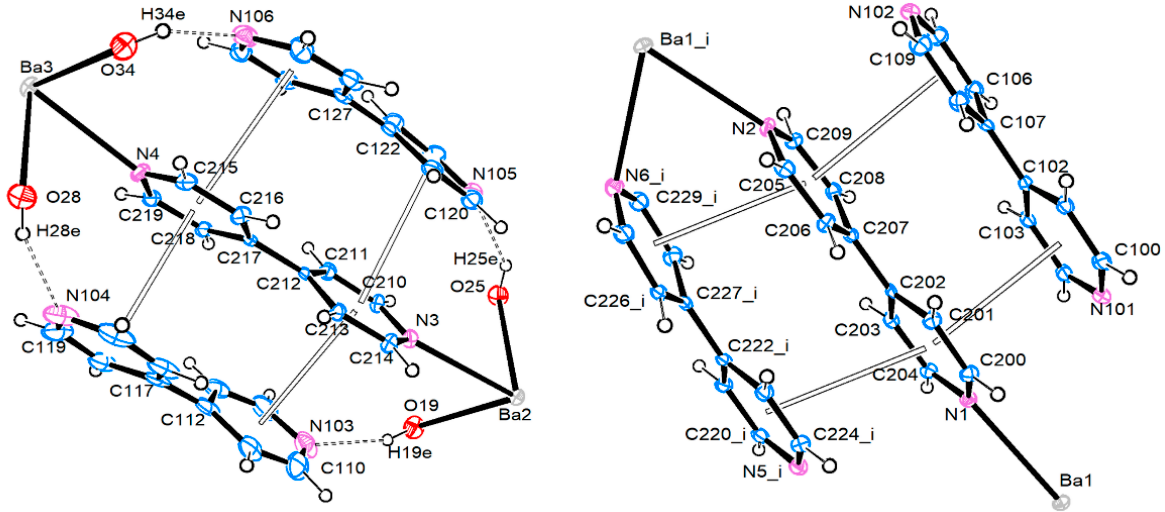
Figure 23 . ( left ) The three anions bridging Ba1, Ba2, and Ba2_i (symm. Code i: − x , 1 − y , z − ½ ). ( right ) The three anions bridging Ba3 and Ba3_i (symm. Code i: − x , 1 − y , z − ½ ).